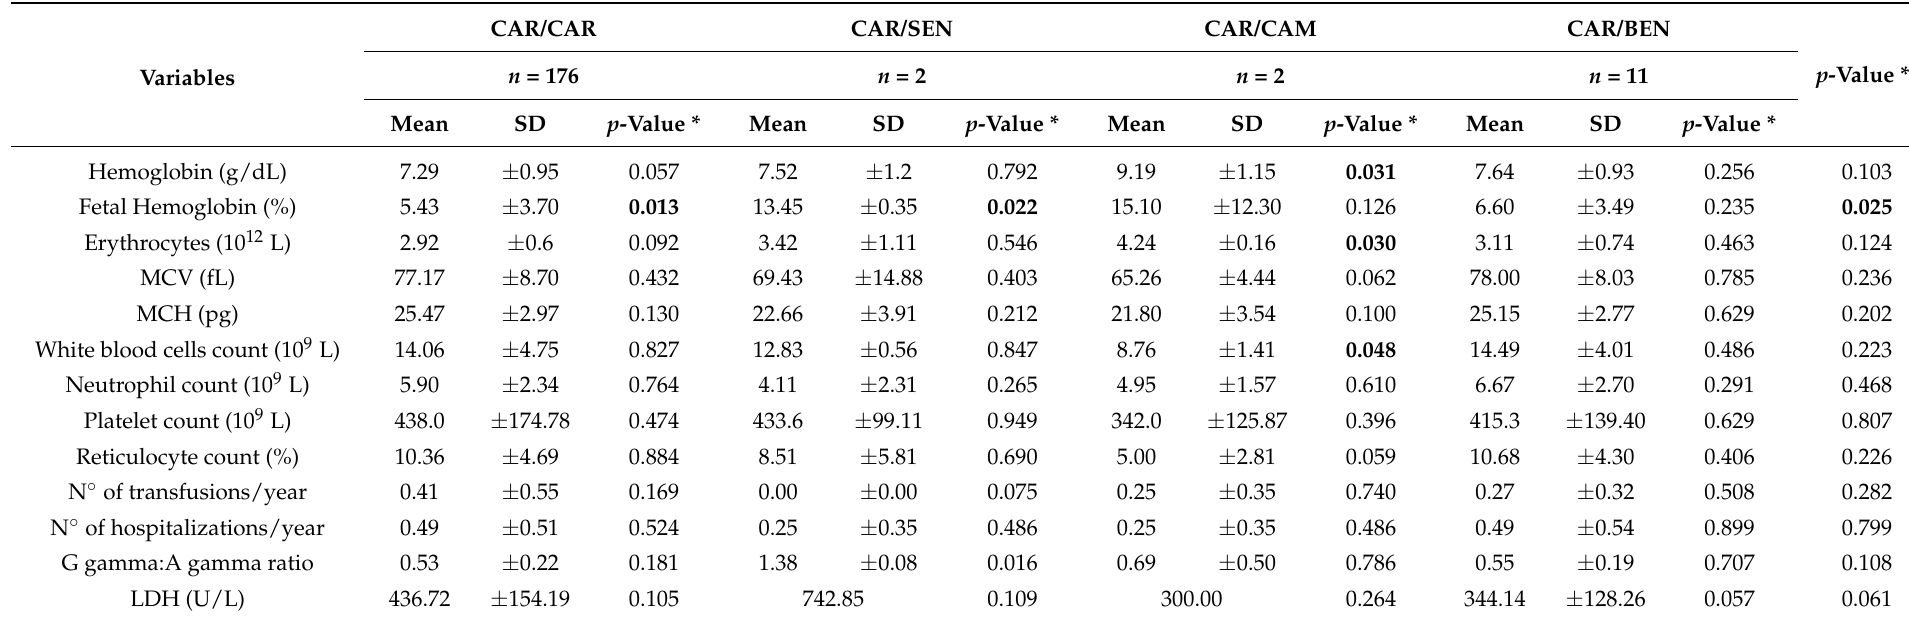
Table 1. Clinical and hematological variables associated with different haplotypes. The Mann–Whitney U test was used for pairwise comparisons for having or not having a particular haplotype and the Kruskal–Wallis test for multiple analysis between the four haplotype groups. Bold values denote statistical significance at the p < 0.05